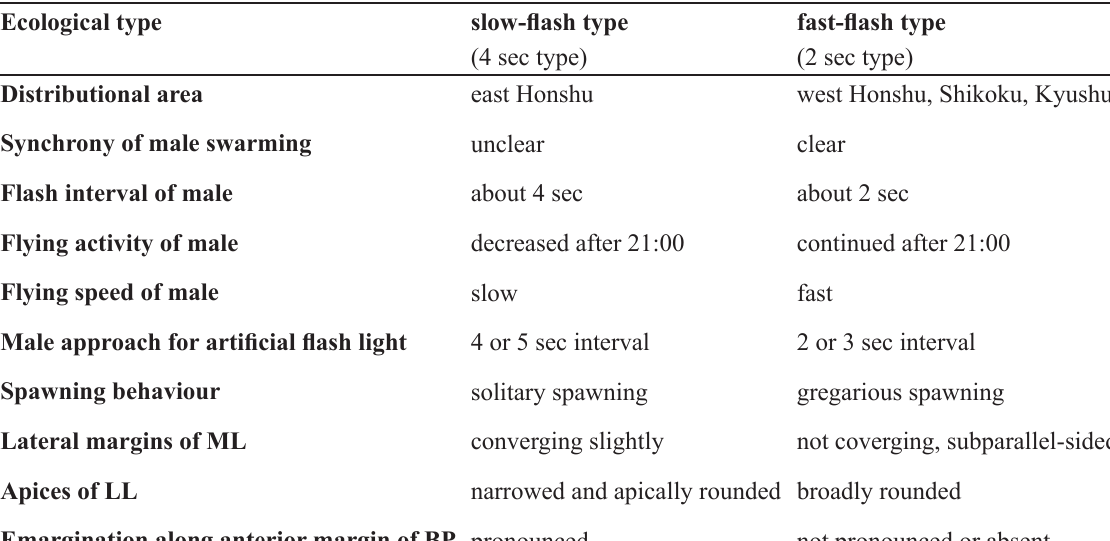
Table 3. Summary of ecological and morphological characters of the slow- and fast-flash types. Ecological